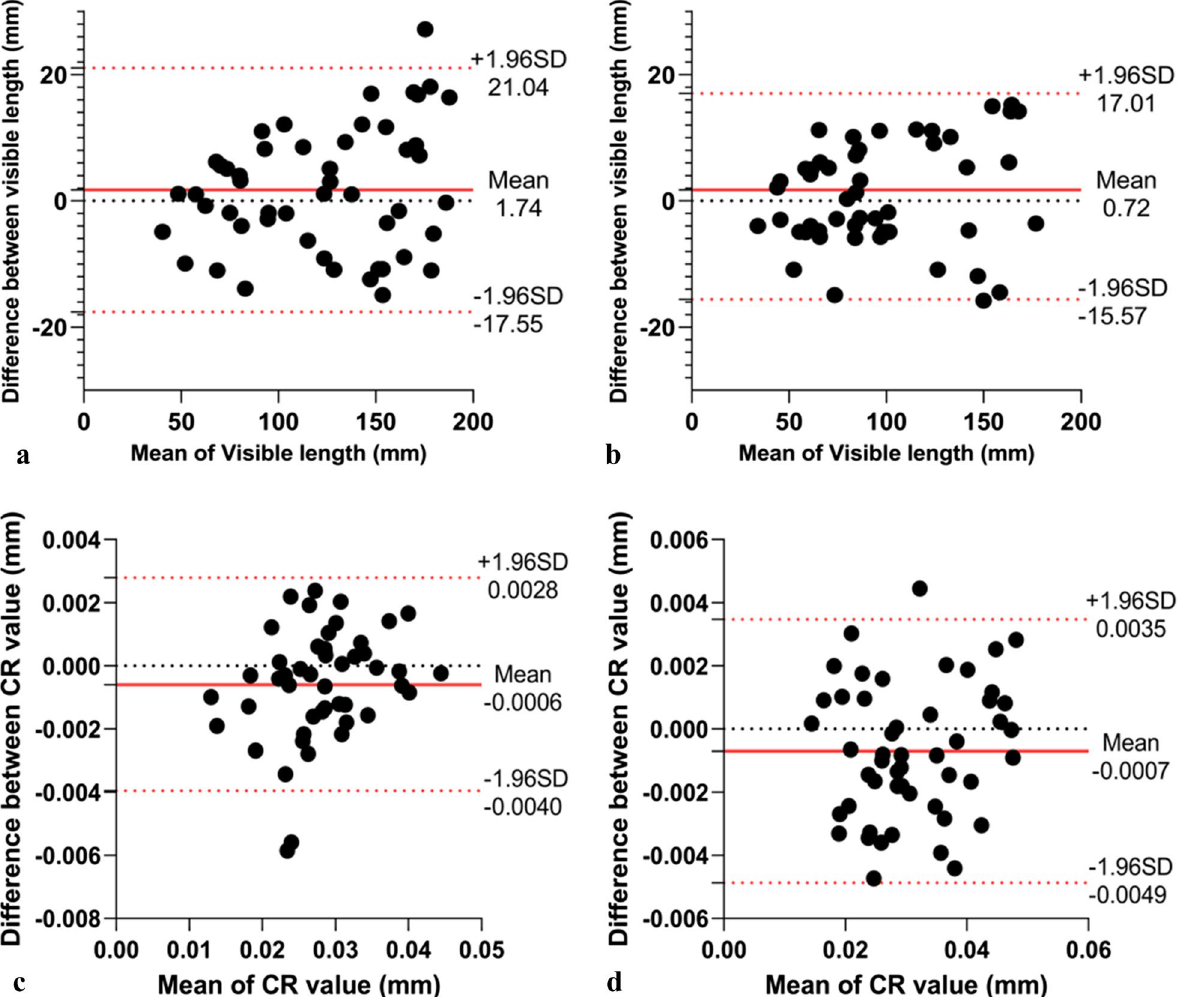
Fig. 7 a , b Bland–Altman analysis of intra- ( a ) and inter-technique ( b ) reproducibility of visible vessel lengths. c , d Bland–Altman analysis of intra- ( c ) and inter-technique ( d ) reproducibility of CR. The solid red line indicates the mean difference; the red dashed lines indicate the 95% limits of the agreement